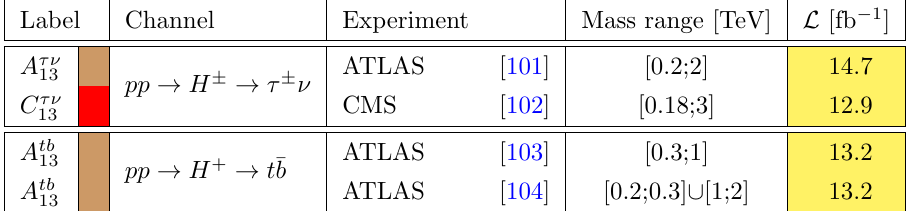
Table 7 . List of the available charged heavy Higgs searches from LHC Run 2 relevant for the 2HDM. For an explanation, see the description below table